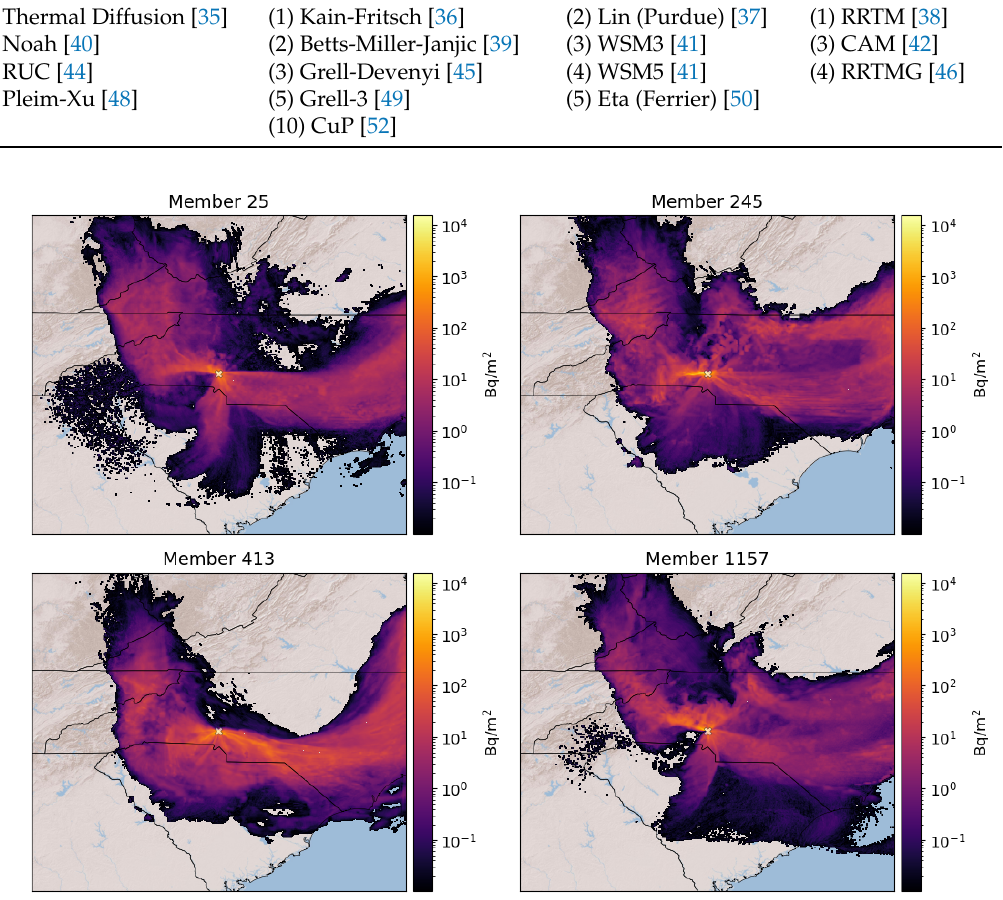
Figure 2. Examples of different deposition maps produced by FLEXPART-WRF for the surface release case. All values below 0.01 Bq/m 2 were removed. The WRF parameterizations used to create each subplot can be found in Section